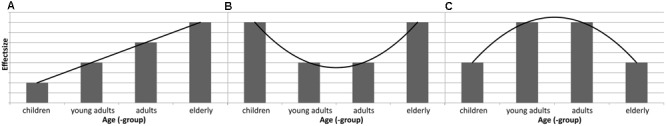
(A) Linear trend of increasing SNAs (y-axis) over the lifespan (x-axis), i.e., children, young adults, middle-aged adults, and elderly; (B) Positive quadratic trend of SNAs over the lifespan; (C) Negative quadratic trend of effect sizes of SNAs over the lifespan.